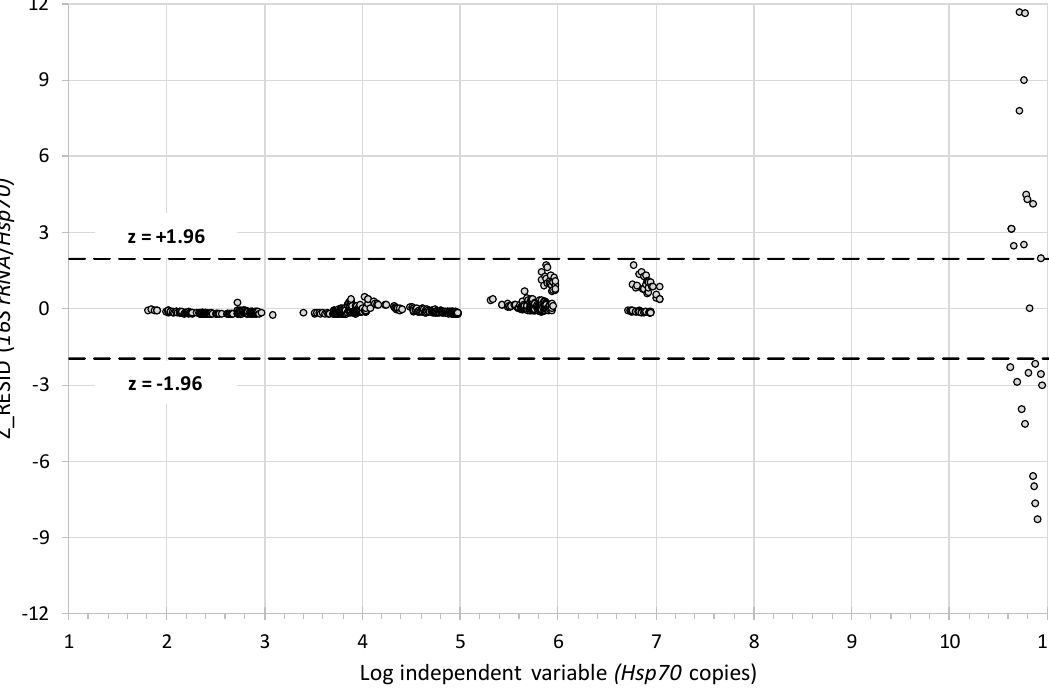
Figure 2. Scatterplot showing the relationship between the error variance of the 16S rRNA / Hsp70 ratio and the abundance measured with the Hsp70 method (N = 875). The interval of the 95% normally distributed data (z = +/− 1.96) is shown as a reference.